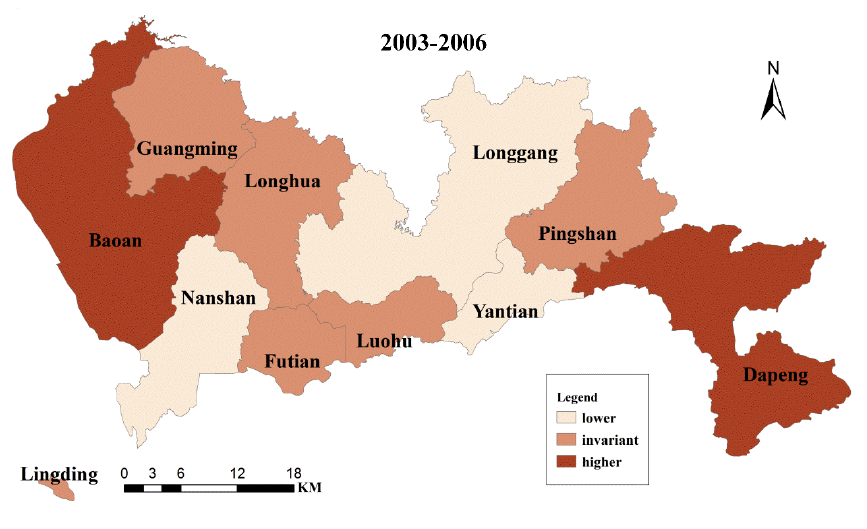
Figure 7. The SR changes every three years and the total SR changes for each district in